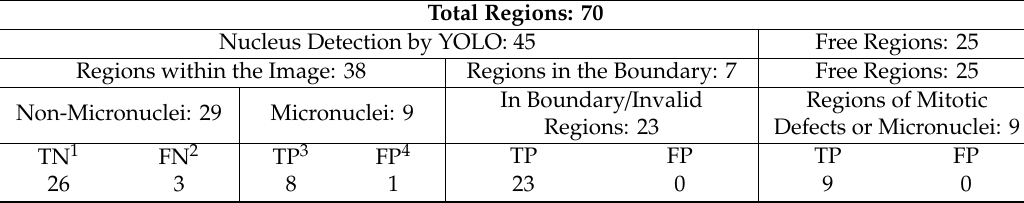
Figure 16. Experiment 1 of the HCT116 cell with dinaciclib (no.4496): ( a ) normal nuclei are distinguished from abnormal nuclei by rectangular boxes; ( b ) histogram of the normal nuclei (non-micronuclei) and the abnormal nuclei (micronuclei/mitotic defects). Table 1. The number of cell nuclei (experiment